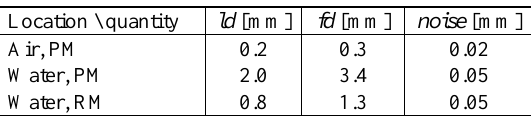
Table 2. Results for the calibration